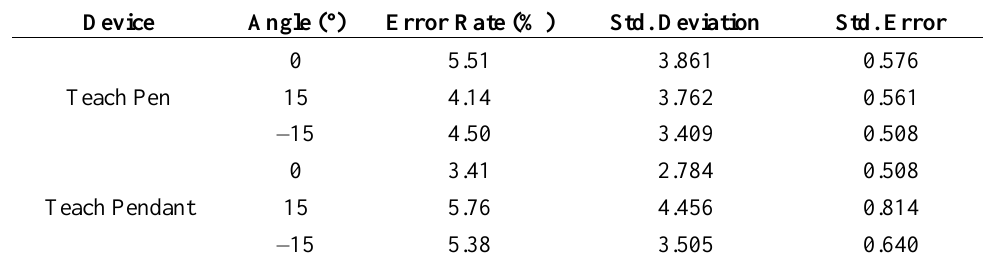
Table 6. Error rate, standard deviation, and standard error for operating the two tools at three inclination angles.